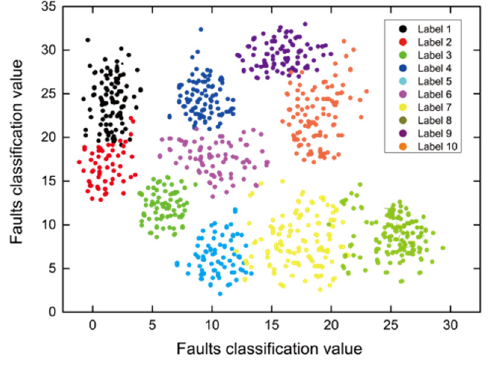
Figure 16. Feature visualization through t ‐ SNE.